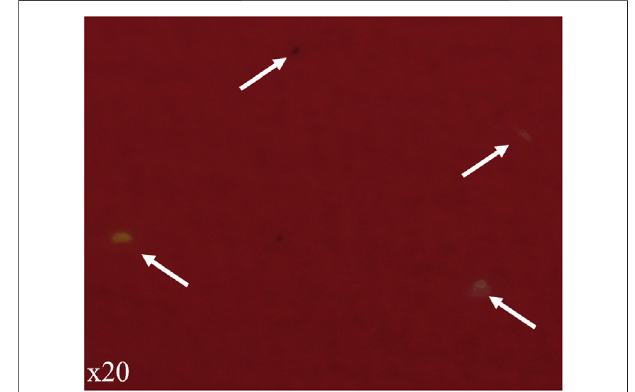
FIGURE 4 | Observation of experimental copepods contaminated with MPs of LDPE and digested on aluminum oxide fi lter. Filter was stained with Nile Red and observed with epi fl uorescence microscopy (crime light: 455 – 494 nm).IngestedMPsandcuticlefragmentswerepresenton fi lter but